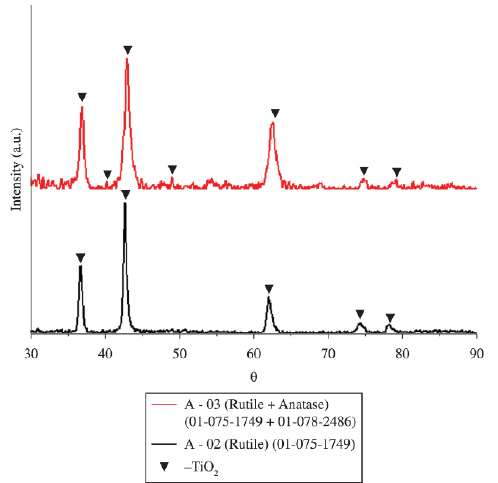
Figure 7. X-Ray diffractogram of double titanium cage deposited glass sample where sample A – 02 was treated at 400ºC and sample A – 03 was treated at 370ºC and for the treatment time lasted 2 hours